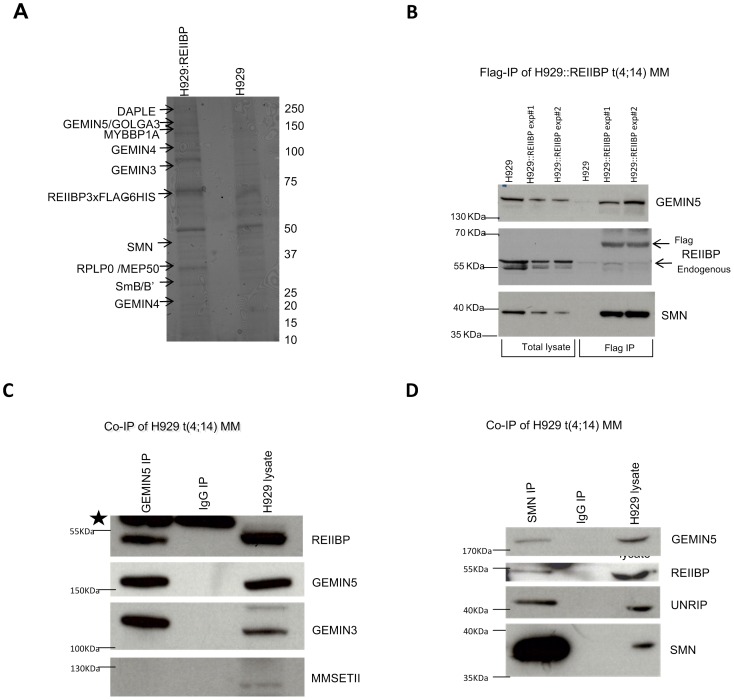
REIIBP interacts with the SMN complex in myeloma t(4;14) cells.A) Identification of REIIBP binding partners. REIIBP protein partners were pulled down by a tandem affinity purification approach. To isolate a protein fraction with a low level of background contaminants, the lysates from H929::REIIBP and H929 (control sample) were passed through two different chromatography columns, an anti-Flag resin and Nickel resin. The purified populations were run on SDS acrylamide gel and stained with Coomassie blue. Discrete bands were cut from the gel and analysed by mass spectrometry. The number on the right indicates the position of the respective molecular weights in KDa. The positions for the proteins identified by Mass spectrometry are shown by arrows. B) Western blot analysis on Flag IP fractions. The names of the respective antibodies used for staining are shown. Molecular weight is shown. C–D) Endogenous REIIBP interacts with the SMN complex in myeloma cells. Co-IPs of GEMIN5 (C) and SMN (D) in t(4;14) untransduced myeloma cells. GEMIN5 and SMN were immuno precipitated from H929 cell lysates using specific antibodies. An IP with normal mouse IgG antibody was used as control. The IPs were resolved in a SDS acrylamide gel and blotted for the indicated antibodies. The black star shows the position for the heavy chains of the antibodies used in the Co-IP. Please note MMSET II in H929 cells has a shorter molecular weight than canonical 150 KDa.